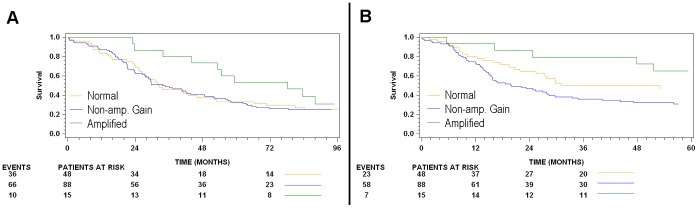
Kaplan-Meier plots illustrating patient outcome according to TOP1 status.A (left): OS, B (right): TTR.